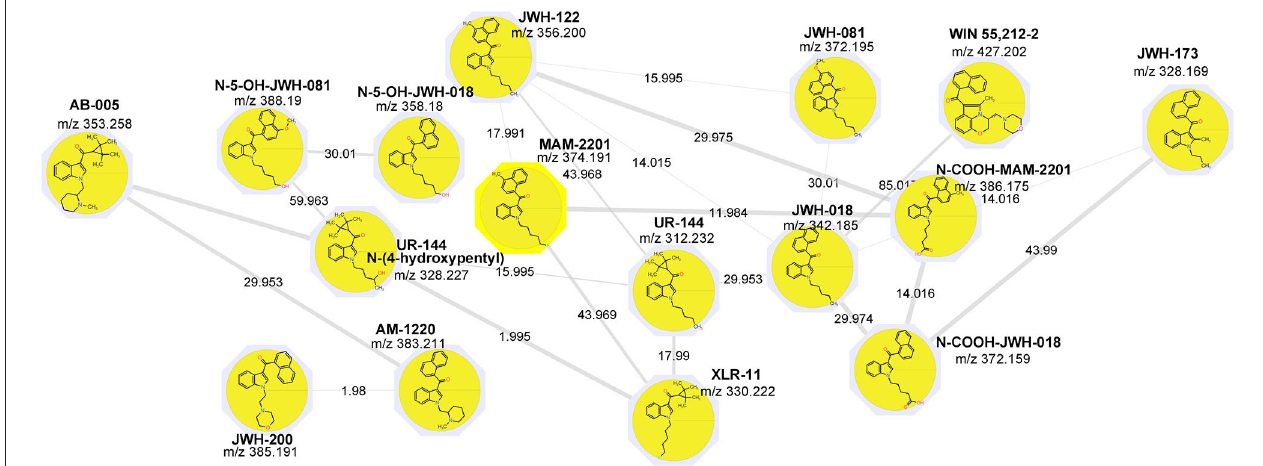
FIGURE 1 | Synthetic cannabinoids network.